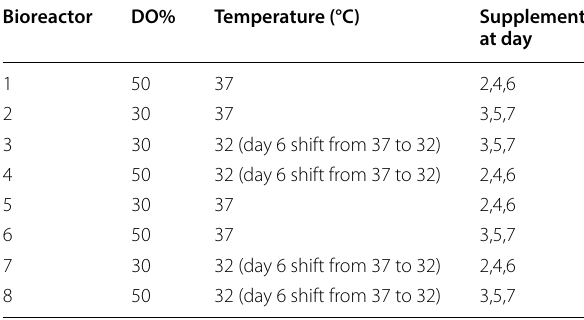
Table 1 DOE evaluation of three cell-culture process